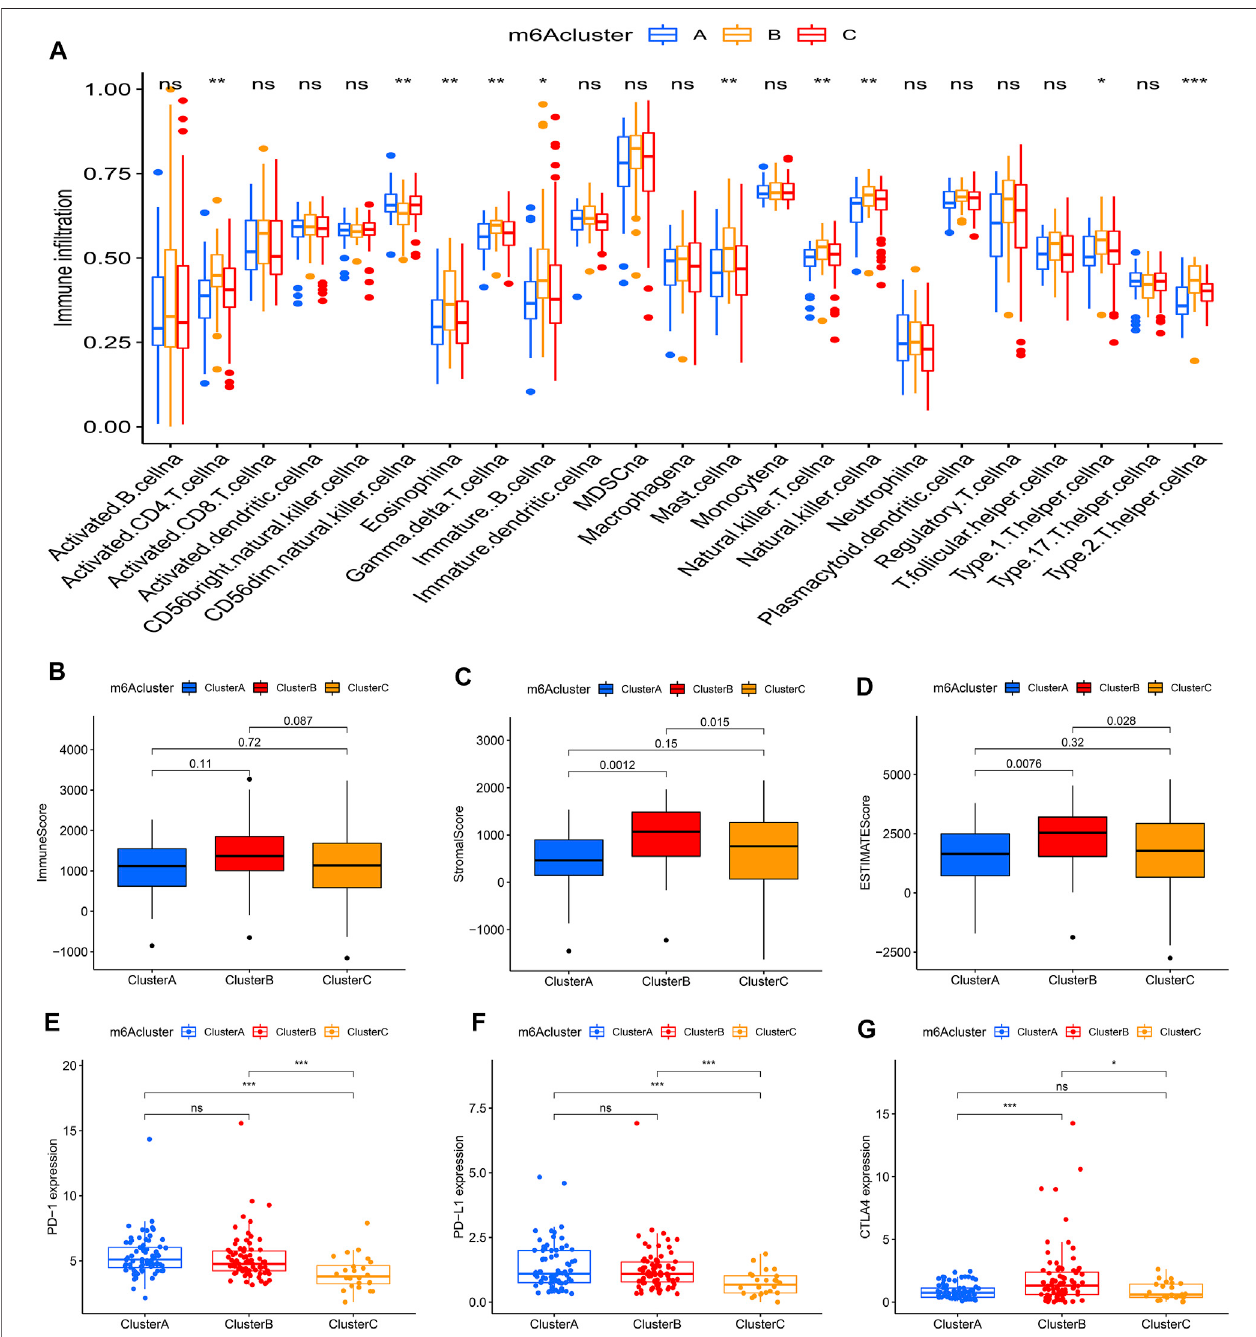
FIGURE 3 | Tumor immune landscapes in distinct m6Aclusters. (A) ssGSEA of patients in distinct m6Aclusters, the asterisks represented the statistical p value (* p < 0.05; ** p < 0.01; *** p < 0.001); (B) Immune score of patients in distinct m6Aclusters; (C) Stromal score of patients in distinct m6Aclusters; (D) ESTIMATE score of patients in distinct m6Aclusters; (E) PD-1 expression of patients in distinct m6Aclusters (* p < 0.05; ** p < 0.01; *** p < 0.001); (F) PD-L1 expression of patients in distinct m6Aclusters (* p < 0.05; ** p < 0.01; *** p < 0.001); (G) CTLA4 expression of patients in distinct m6Aclusters (* p < 0.05; ** p < 0.01; *** p < 0.001).